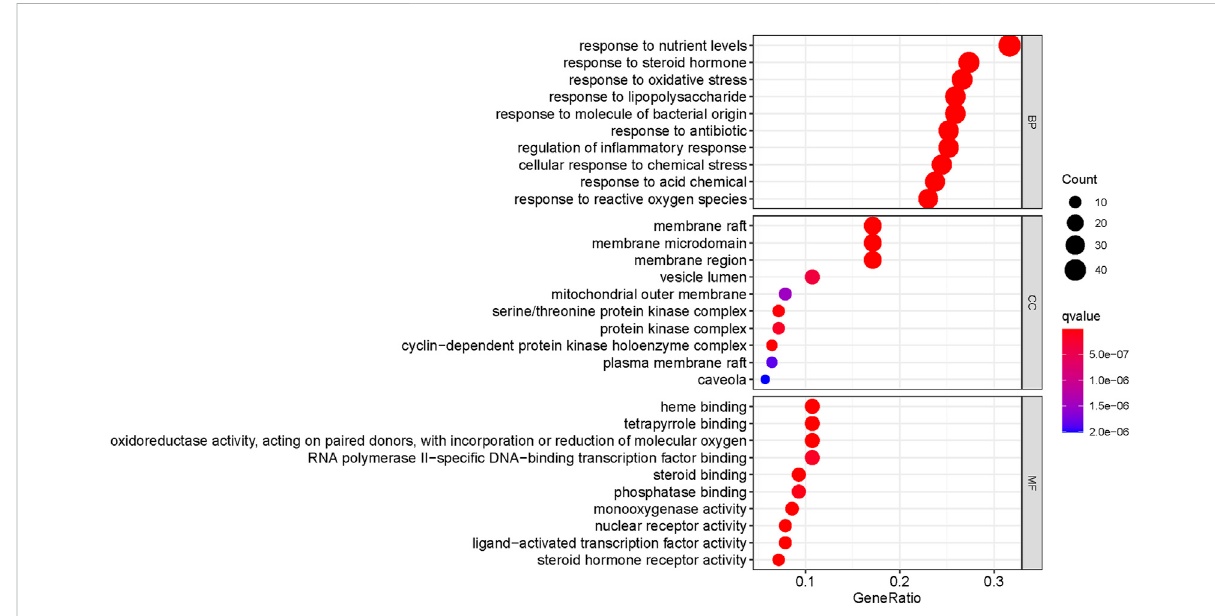
FIGURE 6 Bubble chart of the top 10 GO enriched